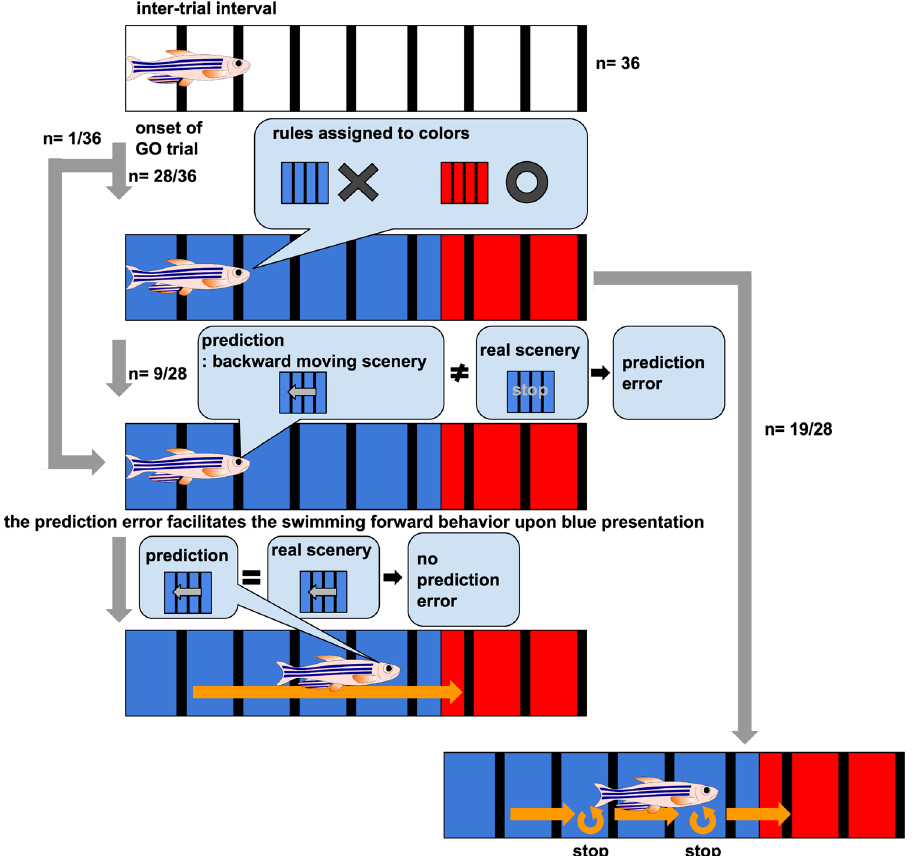
Fig. 9 Schematic illustration showing the relationship between the generated neural ensembles and behaviors. Adult zebra fi sh formed a cognitive map by assigning rules to presented colors and generated the ensemble putatively encoding the scenery fl ow prediction error (SFPE). Activation of the putative SFPE ensemble improved active avoidance